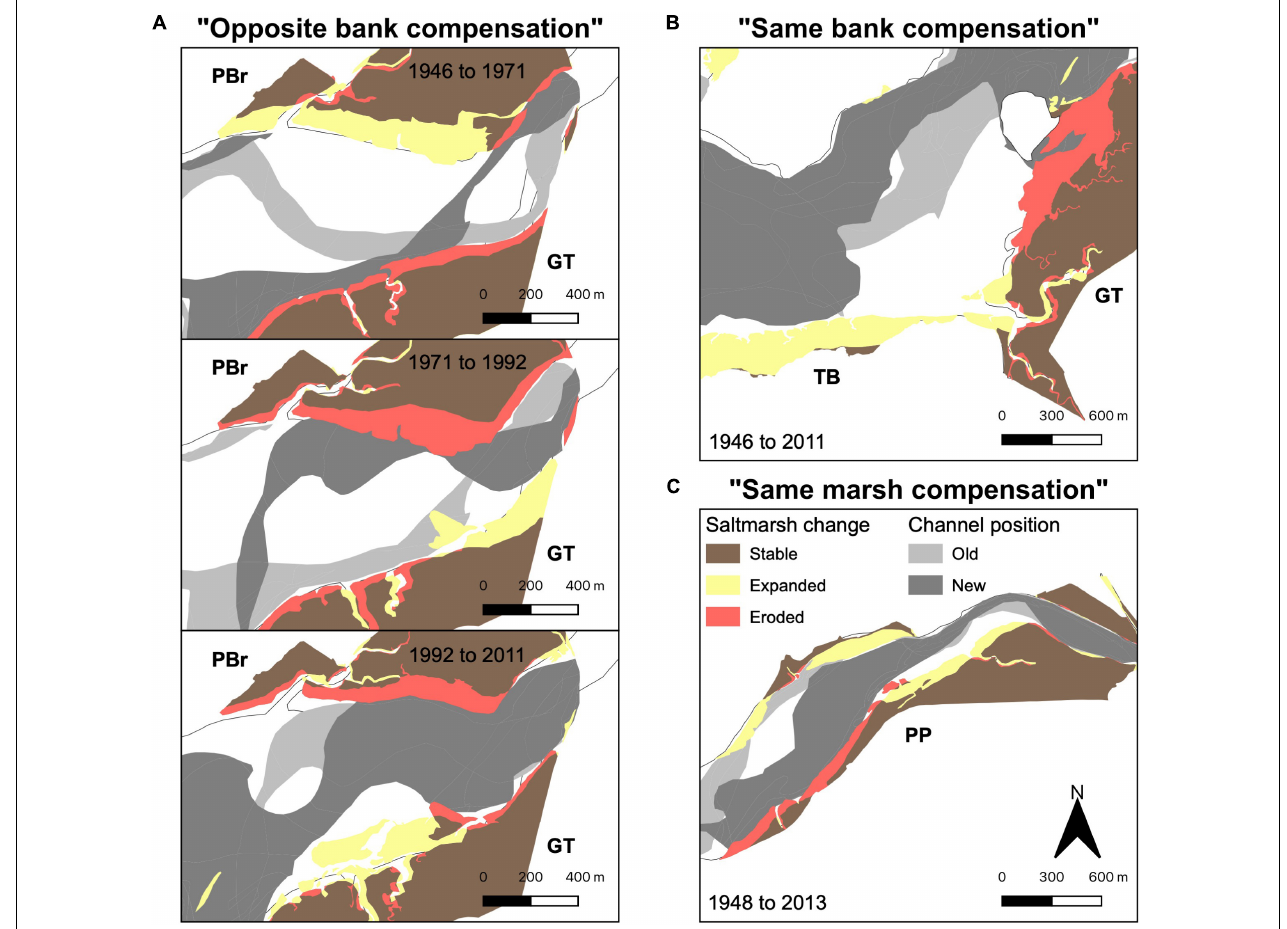
FIGURE 5 | Illustrations of three modes of compensatory coupling of salt marsh erosion and expansion. (A) Opposite bank compensation erosion on one estuary bank is associated with expansion on the opposite bank. (B) “Same bank compensation”: loss at one marsh is followed by expansion at another. (C) “Same marsh compensation”: simultaneous erosion and expansion in the same marsh. Yellow, red and brown represent marsh gain, loss and no change, respectively. Light gray areas demarcate the position of tidal channels in the earlier year, whilst dark gray areas show tidal channel positions in the later year. Figures (B,C) relate to the full study duration, whilst (A) show three timesteps to illustrate cyclicity in switching between estuary banks. Labels refer to the names of salt marsh complexes (GC, Glaslyn Cob; TB, Traeth Bach; GT, Glastraeth; PBr, Pont Briwet; FB, Fairbourne; DW, Dwynant; GI, Garth Isaf; PP, Penmaenpool, and; PBo, Pont Borthwnog). Changes in marsh and channel configuration for each timestep can be seen in Supplementary Figures 2–4